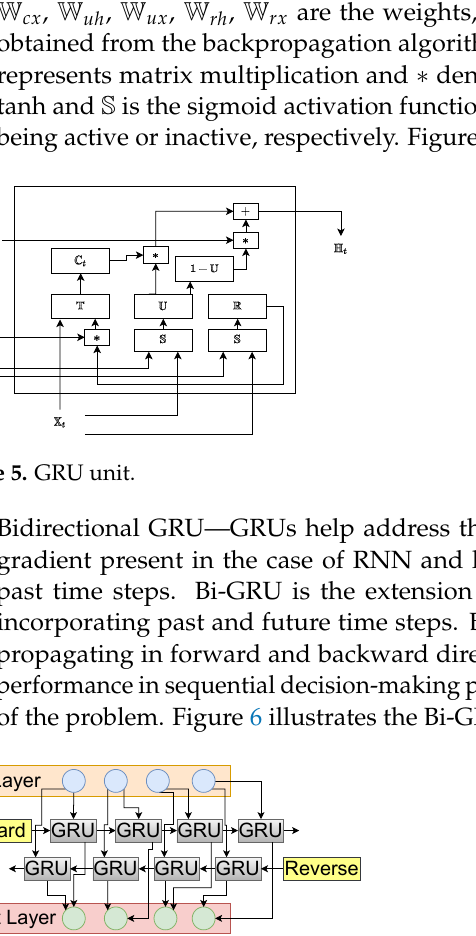
Figure 6. Bi-GRU architectural